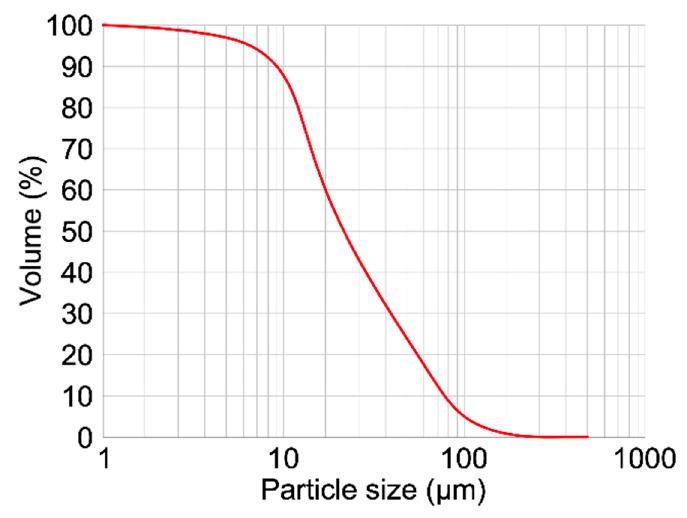
Figure 2. The size distribution curve of potassium feldspar grade FK-100.